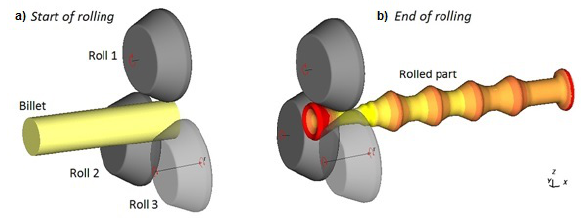
Figure 3: Geometrical model of the skew rolling process for pro- ducing a crankshaft preform: a) start of the process, b) end of the process.